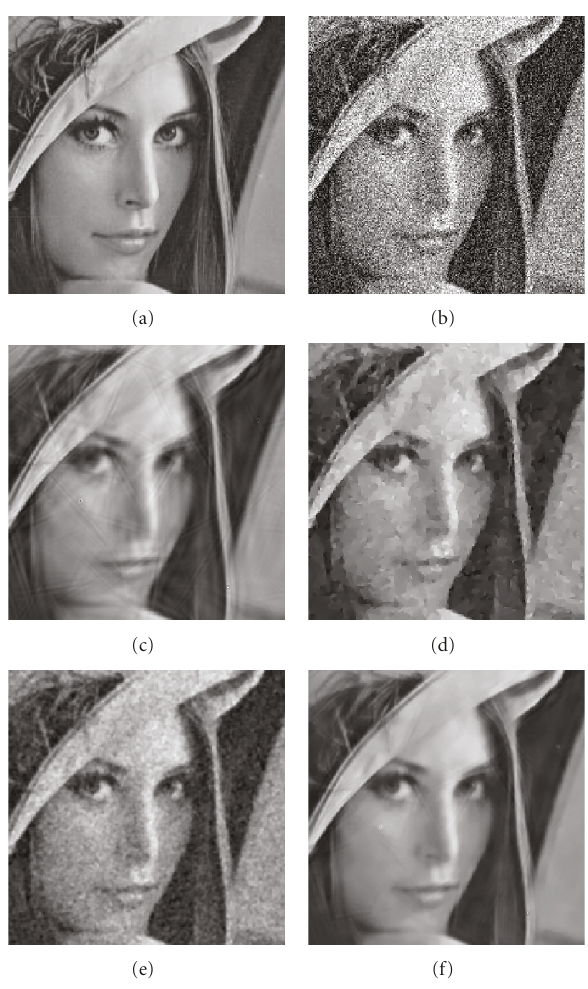
Figure 10: The subimages of the original, noisy, and restored “Lena”: (a) the original image; (b) the noisy image (SNR = 1.54, MSSIM = 0.15); (c) the restored image by the curvelet shrinkage method (SNR = 13.72, MSSIM = 0.79); (d) the restored image by using the “TV” model (SNR = 12.94, MSSIM = 0.71); (e) the restored image by using the “TVGF” model (SNR = 12.01, MSSIM = 0.61); (f) the restored image by using the proposed model (SNR = 14.36, MSSIM = 0.82).